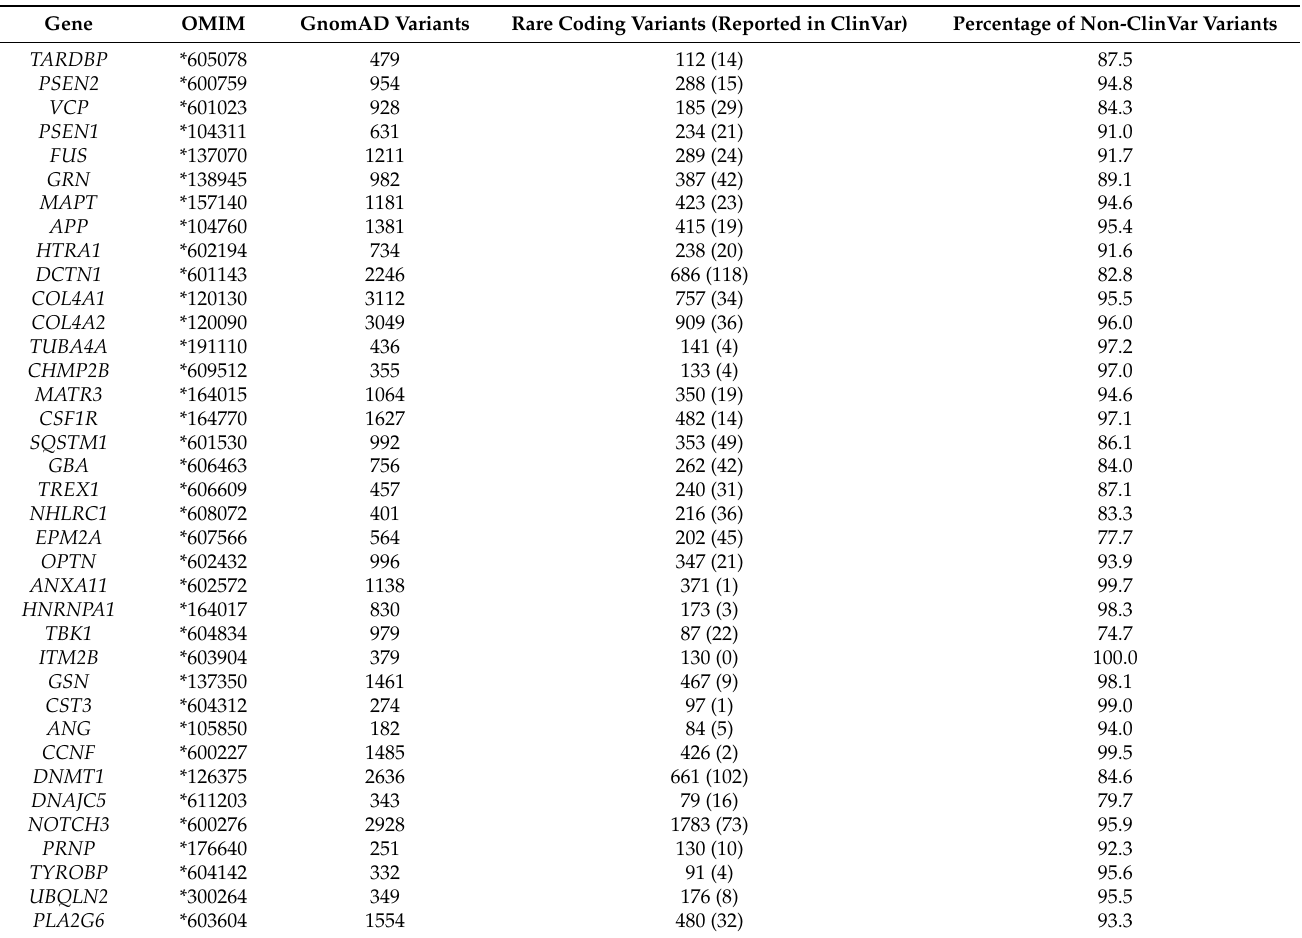
Table 2. Burden of rare genetic variants in dementing genes. For each gene, the table provide: total number of described variants in GnomAD database (3rd column), total rare coding variants (coding variants with allele count < 5) and rare coding variants described in ClinVar international database (4th column), percentage of rare variants not listed in ClinVar database (5th